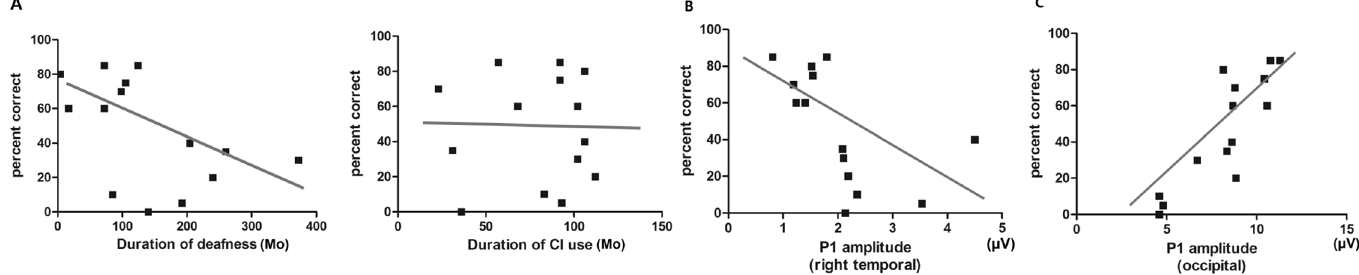
Fig 5. Correlation of P1 amplitude in right temporal and occipital cortex with speech perception performance in cochlear implant recipients. (A) Duration of deafness, the most popular prognostic factor of cochlear implant, had the tendency to correlate with PB word score but without statistical significance. (r = -0.527, P = 0.053, Spearman correlation test) Duration of CI use did not have correlation with PB word score. (r = -0.049, P = 0.869). (B) P1 amplitude in right temporal cortex had significant negative correlation with PB word score. (r = -0.736, P = 0.003) This can be associated with persistent right auditory cortical reactivity to visual stimuli even after implantation. (C) Also, P1 amplitude occipital cortex had significant positive correlation with PB word score. This high occipital reactivity was regarded as the extent of visual compensation for imperfect auditory input with implantation. The P1 amplitude of occipital area was much higher compared to temporal area (r = 0.775, P = 0.001).